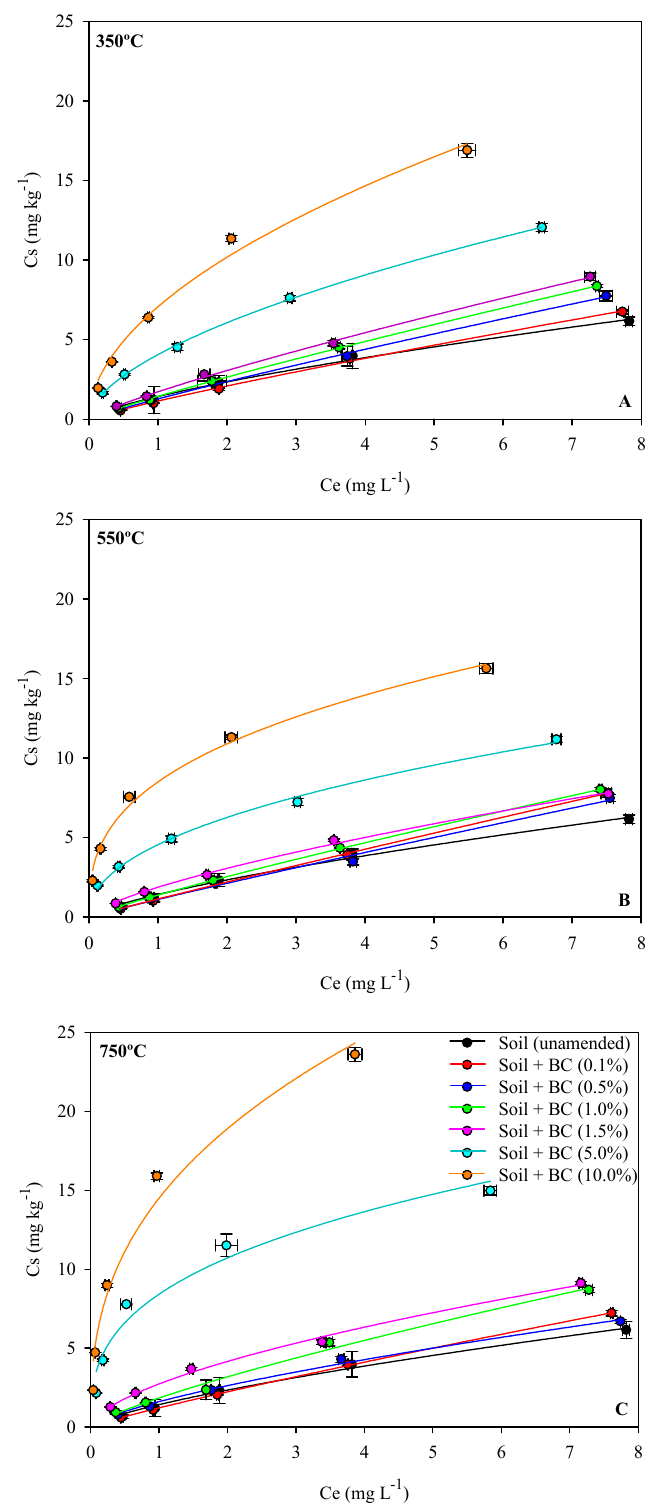
Figure 2. Sorption isotherms of the Freundlich model of metribuzin applied in soil amended and unamended (control) with sugarcane straw biochar (BC) produced at pyrolysis temperatures of 350 °C ( A ), 550 °C ( B ) and 750 °C ( C ). The vertical and horizontal bars represent standard error ( n = 3) of Ce (equilibrium concentration) and Cs (soil concentration). Symbols can cover the bars.